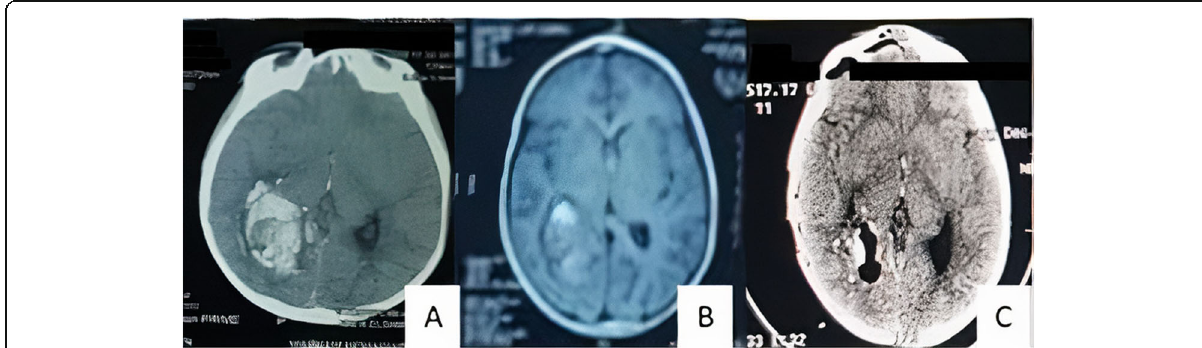
Fig. 4 a Preoperative CT brain. b Preoperative MRI without contrast. c CT brain 1 day after surgery